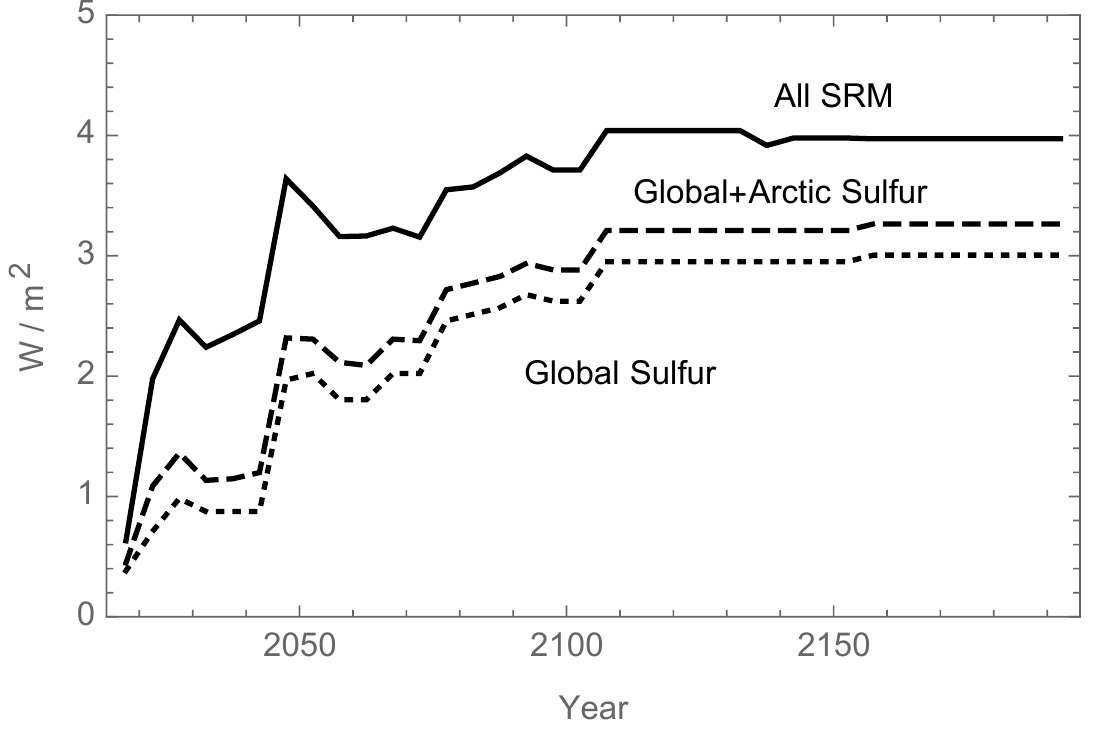
Figure 7. Global albedo modification for solar radiation management, by